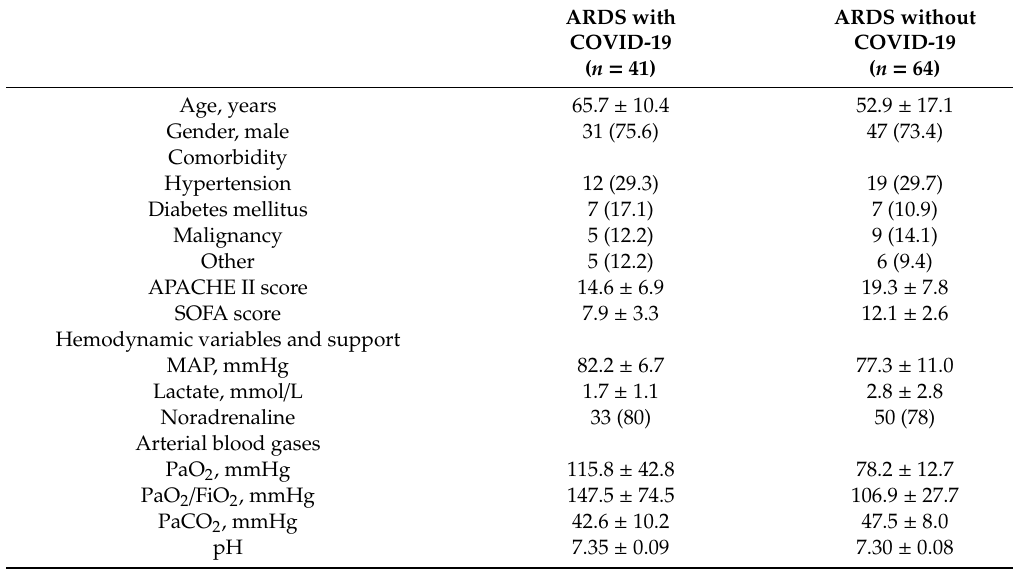
Table 3. Comparison of intubated ARDS patients with COVID-19 with an historical control group of patients with ARDS without COVID-19 [16] a.